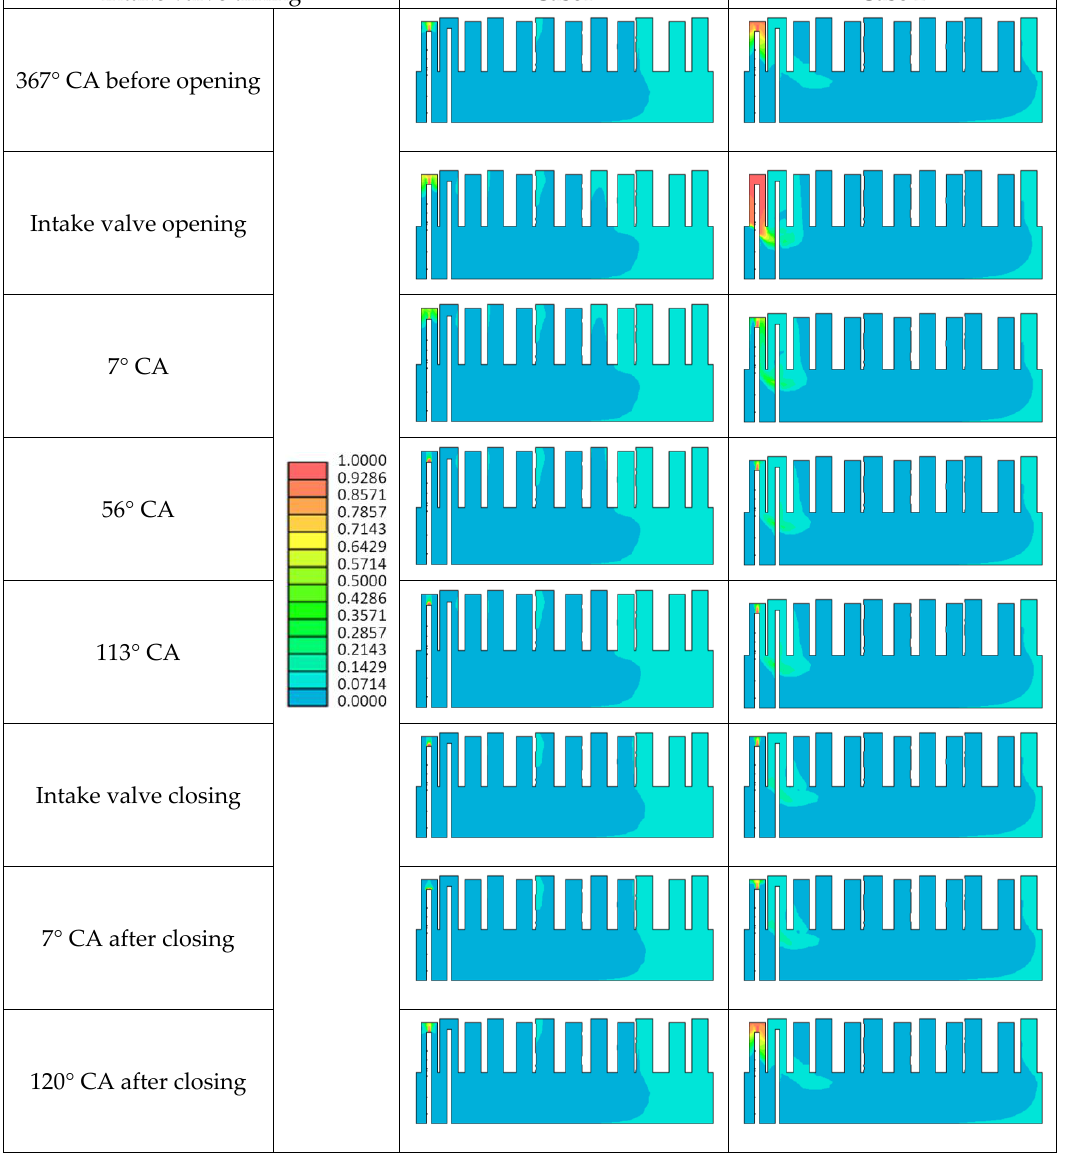
Figure 6. Distribution contour of the mass fraction of CO 2 during the intake process.